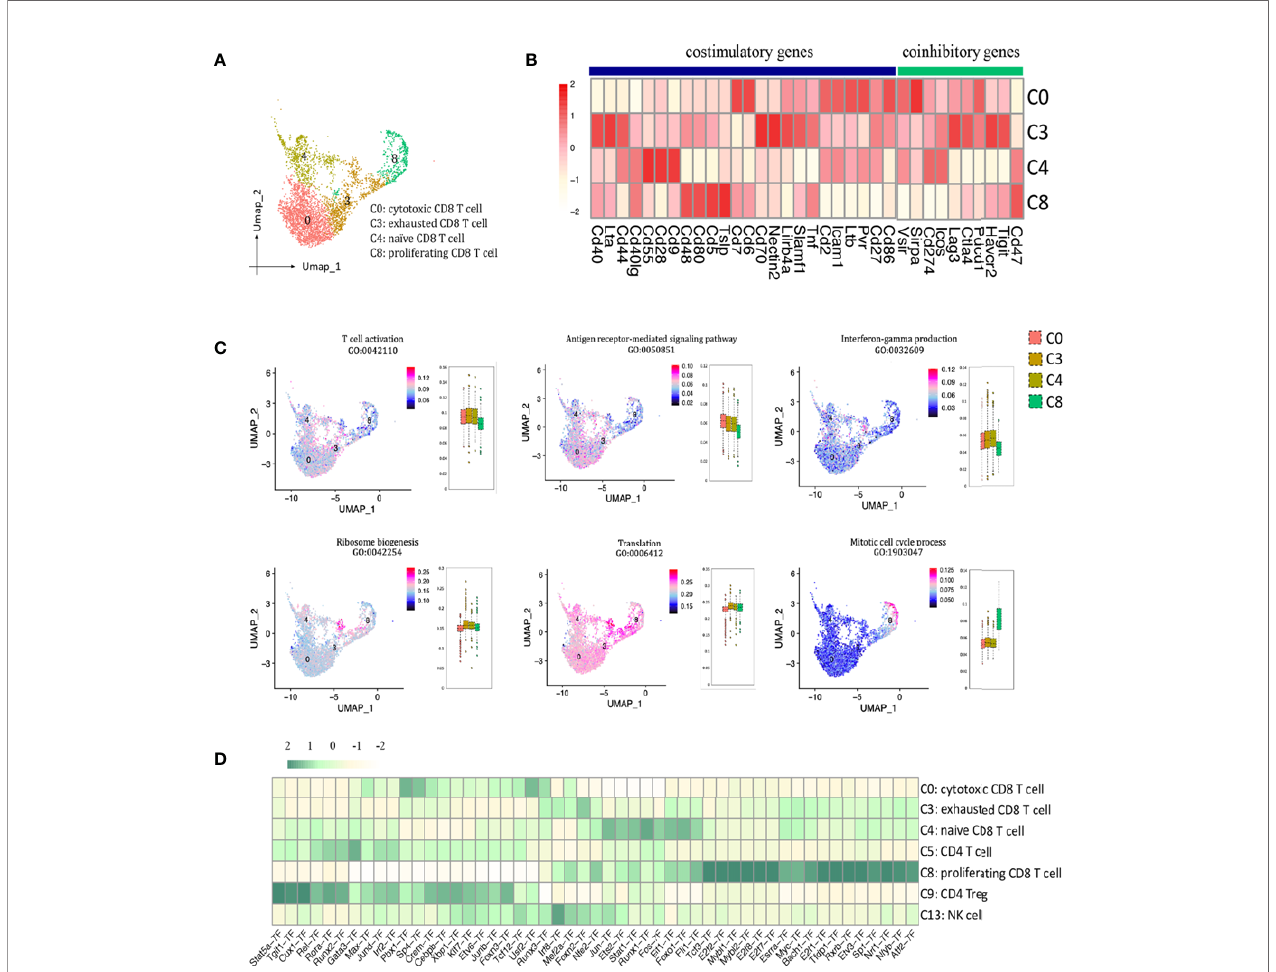
FIGURE 6 | CD8 T cell presented in the allografted kidneys. (A) Integrated UMAP projection of the four CD8 T cell clusters identi fi ed in the kidney grafts (clusters 0, 3, 4 and 8), colored according to cluster designation. Cell identities are annotated on the right. (B) Heatmap showing costimulatory and coinhibitory genes in CD8 T cell clusters. Scale bar is shown on the left. (C) Feature plots showing AUC scores of GO pathways in CD8 T cell. Cell identities are annotated above the cell cluster. Score bar is shown on the right. (D) Heatmap of the area under the curve scores for the expression of gene sets regulated by transcription factors, as estimated with SCENIC, in CD8 T cell, CD4 T cell and NK cell clusters. Scaled AUC score bar is shown above. UMAP, Uniform Manifold Approximation and Projection; AUC, area under the curve; SCENIC, single-cell regulatory network inference and clustering; NK, natural